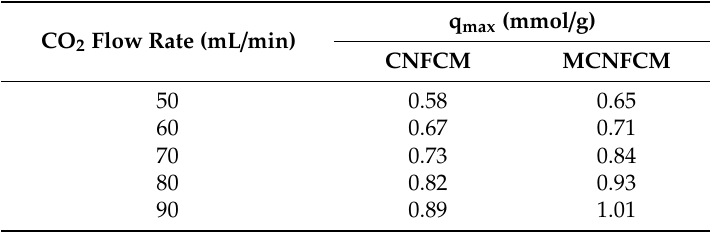
Table 8. CO 2 adsorption over di ff erent flow rates.